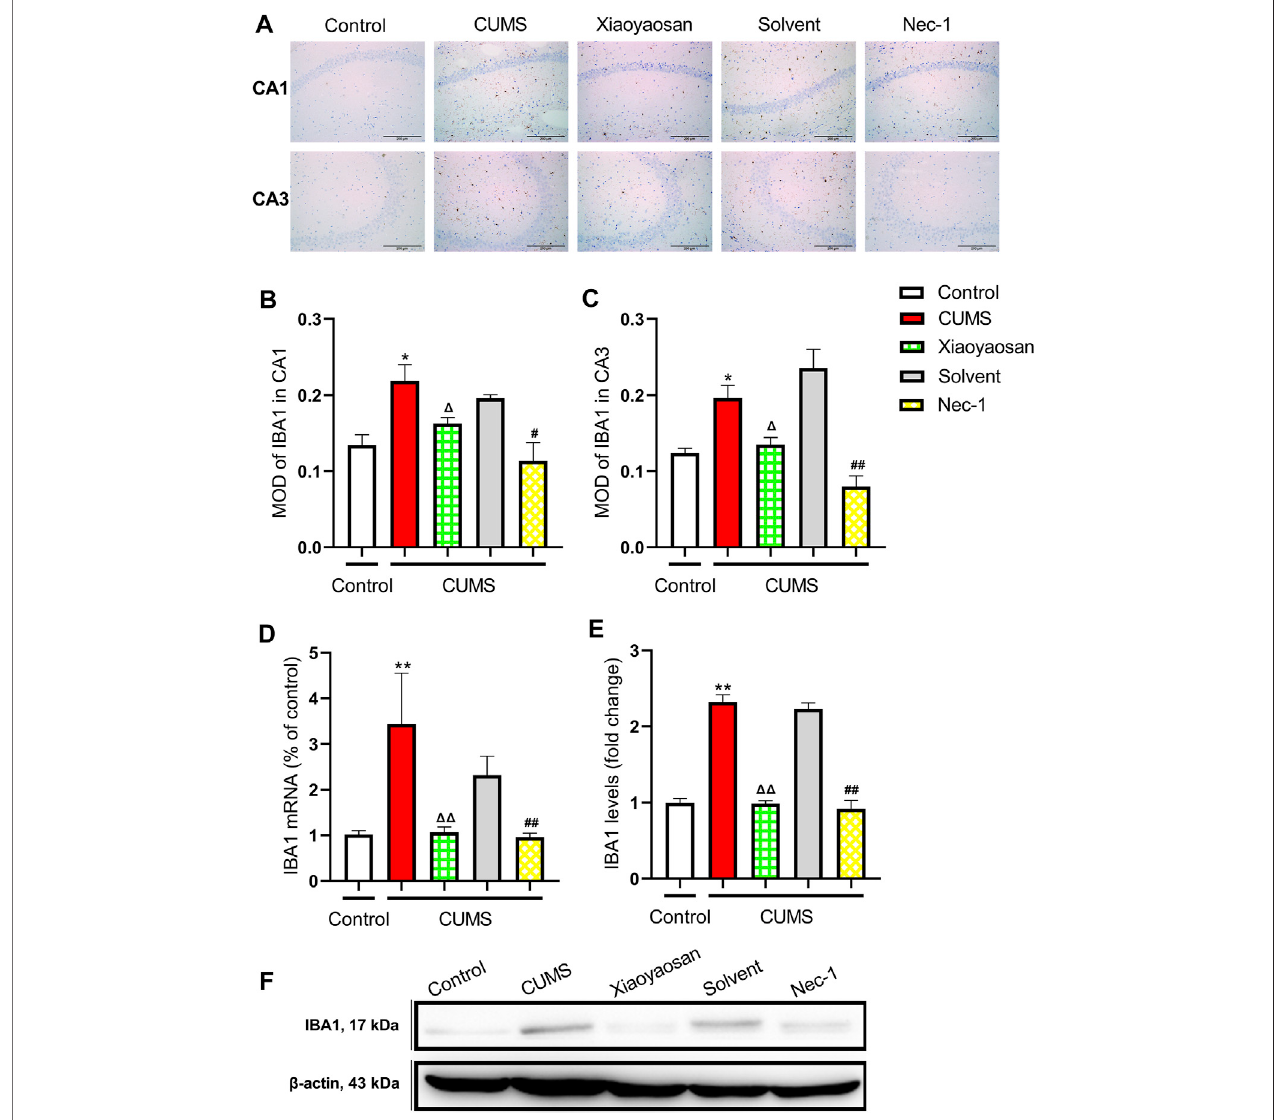
FIGURE 11 | Expression of IBA1 in CA1 and CA3 regions of the hippocampi in CUMS mice (A) Representative micrographs of immunohistochemical staining for IBA1 (scale bar (cid:1) 200 μ m, × 400 magni fi cation) in the CA1 and CA3 regions (B) The MOD level of IBA1 in the CA1 region (n (cid:1) 5) (C) The MOD level of IBA1 in the CA3 region (n (cid:1) 5) (D) The mRNA results of IBA1 (n (cid:1) 5) (E) The protein results of IBA1 (n (cid:1) 5). Data were expressed as means ± SEM, * p < 0.05, ** p < 0.01 versus control group; Δ p < 0.05, ΔΔ p < 0.01 versus CUMS group; # p < 0.05, ## p < 0.01 versus Solvent group.